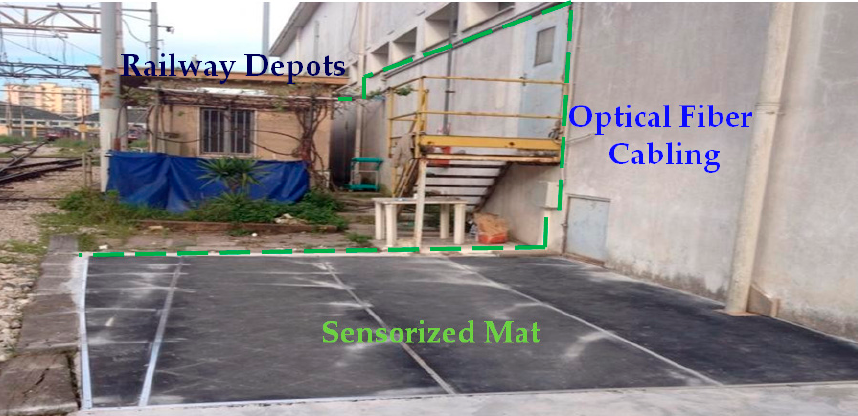
Figure 21. Intrusion detection system in a railway asset installed at the entry point of the Ponticelli depot. Reproduced with permission from ref. [161] (the figure is released under a Copyright Clearance Center’s RightsLink ® service).